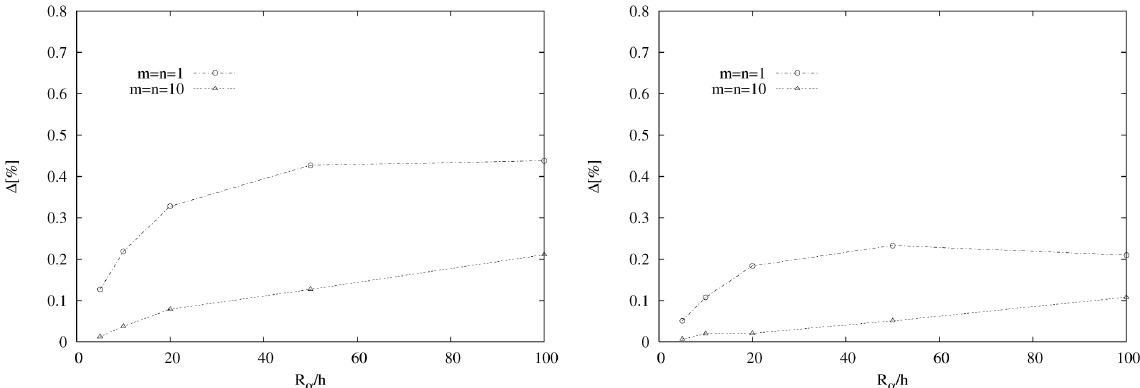
Fig. 4. Thermo-mechanical coupling in one-layered (on the left) and two-layered (on the right) isotropic shells for different values of thickness ratio. Thermo-mechanical coupling parameter Δ(%) = f TM − f